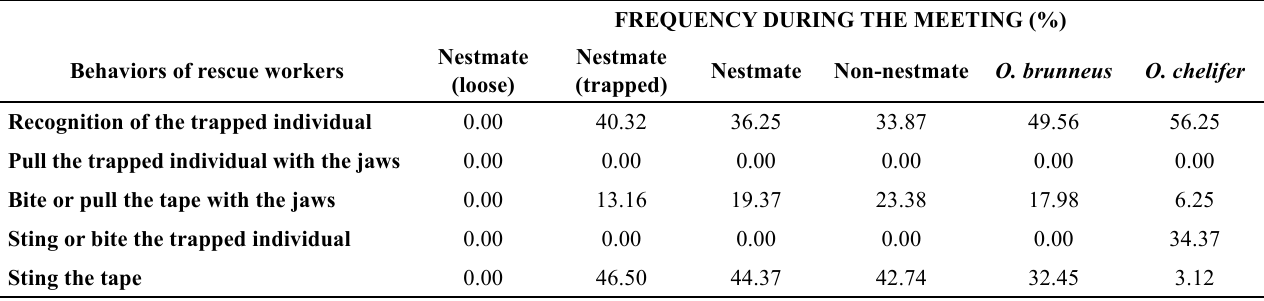
Sting or bite the trapped